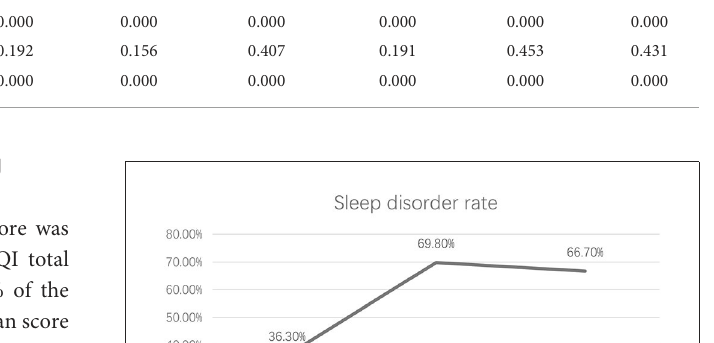
without PTSD symptom; the overall incidence of sleep disorders was 36.3%. Among the 96 participants with mild or moderate PTSD symptoms, 67 had sleep disorders, and the incidence of sleep disorders was 69.8%. Among the 72 participants with severe PTSD symptoms, 48 had sleep disorders, and the incidence of sleep disorders was 66.7%. The overall developing curve showed an upward trend first and then entered a plateau (Figure 2). The incidence of sleep disorders corresponding to varying degrees of PTSD was tested by chi-square test, and the difference was statistically significant ( χ 2 = 61.645, P < 0.001)